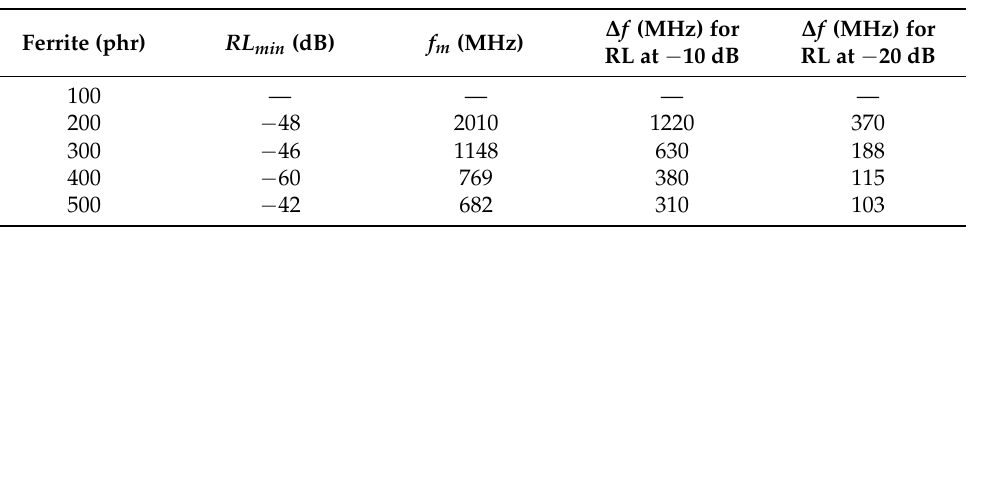
Table 2. Electromagnetic absorption characteristics of ferrite filled